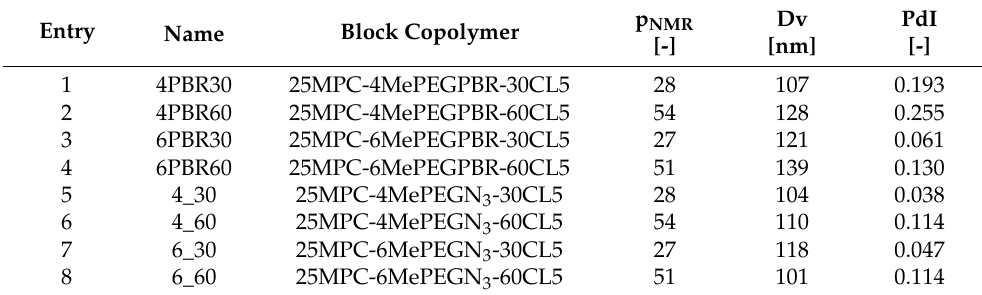
Table 3. Nanoparticle characterization in terms of degree of polymerization of the hydrophobic portion as determined q NMR via 1 H-NMR (p NMR ), volume-average diameter (Dv) and polydispersity (PdI) as obtained through dynamic light scattering